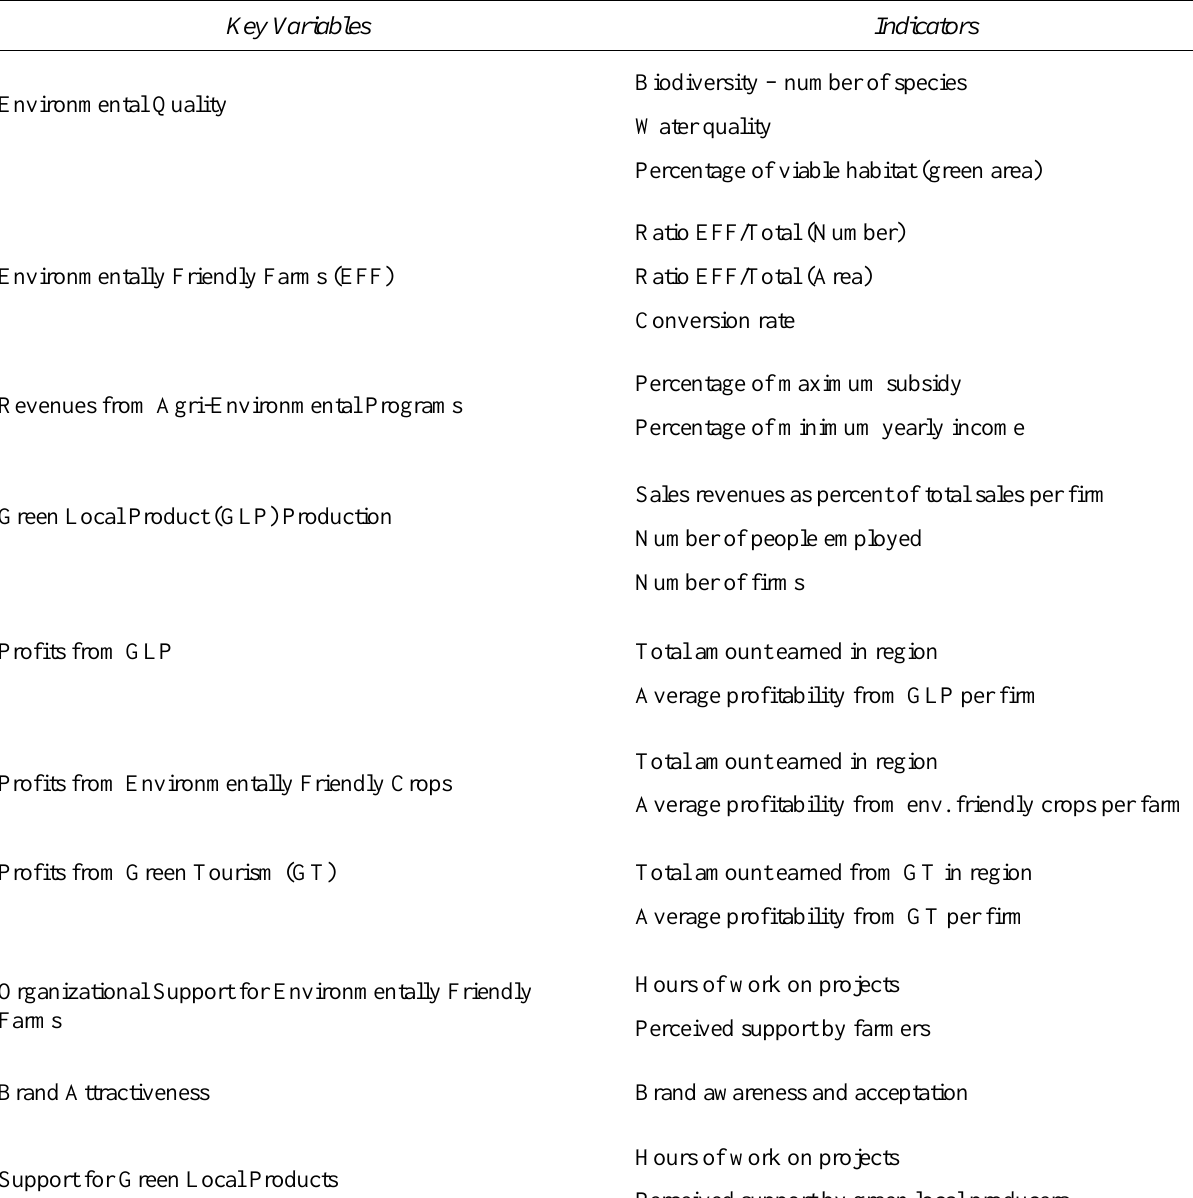
Table 1 : Key variables and indicators that describe